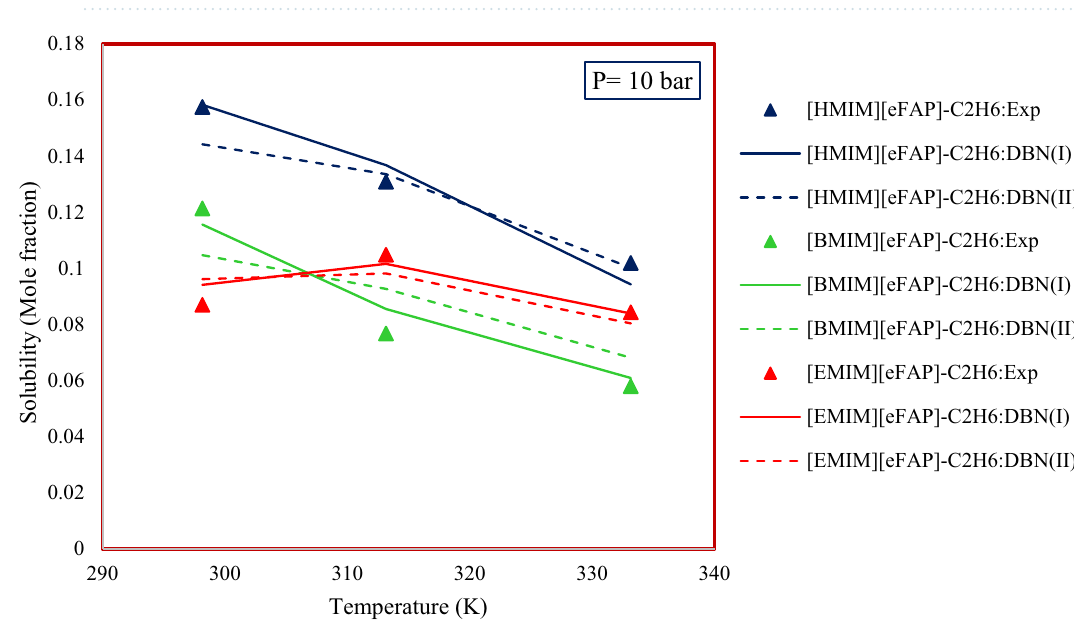
Figure 16. Cation type effect on the solubility of gaseous hydrocarbons in ionic liquids.